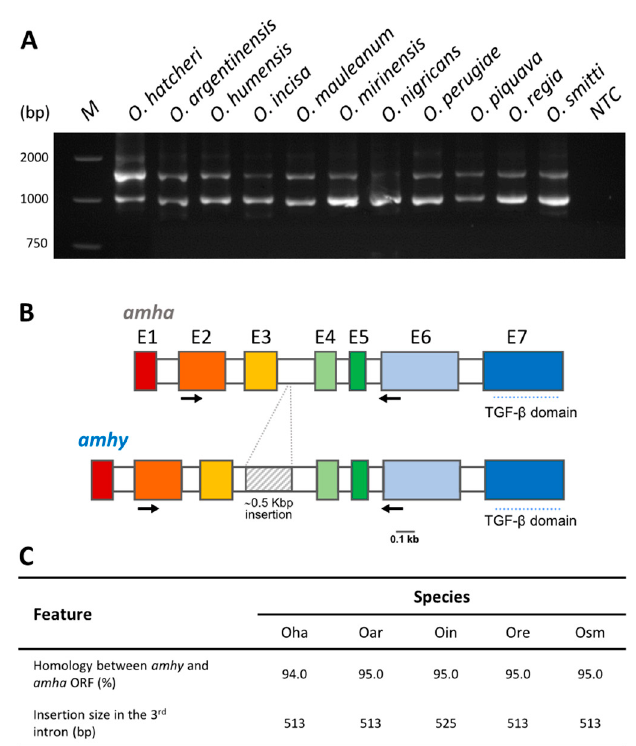
Figure 2. amhy gene amplification pattern, gene structure, and nucleotide sequence comparison Odontesthes species. ( A ) Pattern of amhy (upper band) and amha (lower band) amplification using primers flanking the third intron in presumable genotypic males. M: molecular weight marker; NTC: non-template control. ( B ) Schematic representation of amhy and amha gene structure in the four key Odontesthes species. Exons (E1 to E7) are represented by colored boxes and introns by open boxes; corresponding exons of each locus are represented by the same color. The gray box represents the insertion in the third intron. Arrows indicate the position of primers used in ( A ). ( C ) Nucleotide identity comparison of predicted amha and amhy Open reading frames and the size of insertion in the third intron. Oha: Odontesthes hatcheri ; Oar: O. argentinensis; Oin: O. incisa; Ore: O. regia; Osm: O. smitti .